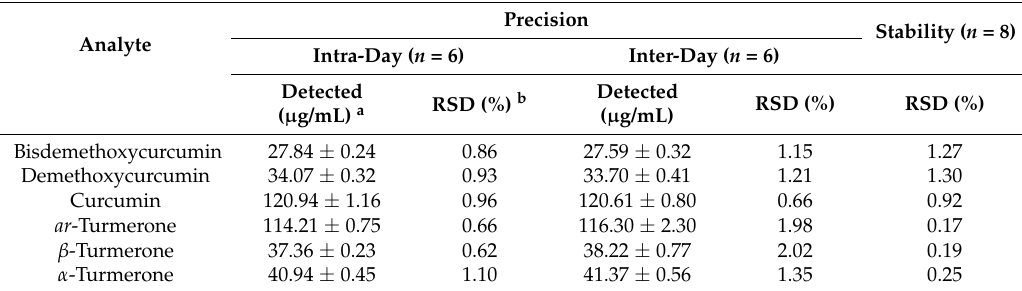
Table 2. Precision and stability of the six analytes.